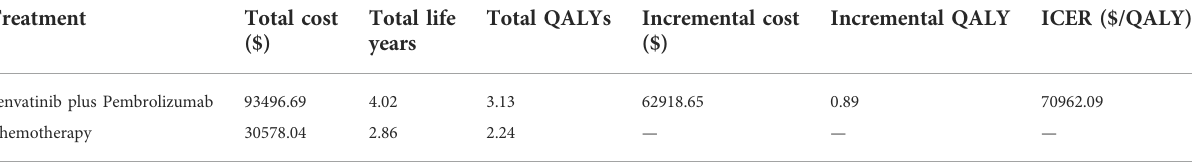
Figure 2. The most in fl uential parameters were the cost of pembrolizumab, cycle of lenvatinib plus pembrolizumab used. However, changing those two factors did not result in signi fi cant changes in the ICER to below the WTP thresholds.